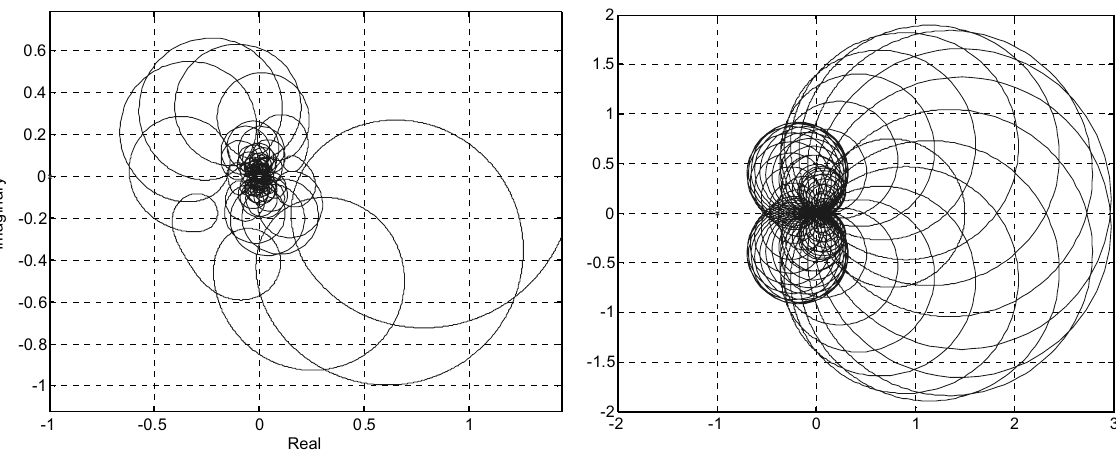
Fig. 6. Nyquist plot of the non-collocated systems 4 with RAVS controller. Left- the system in Fig. 4, right - the system in Fig.